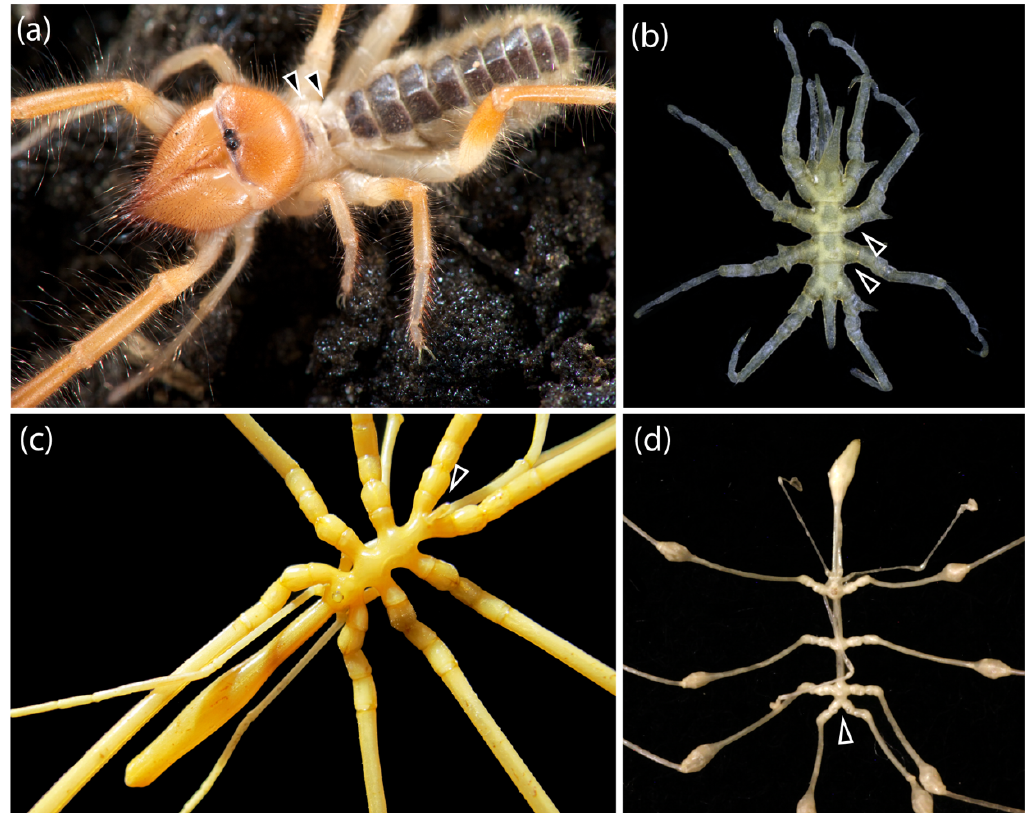
Figure 6. Incorrect codings of morphological character states underlie the recovery of Arachnida in morphological matrices. ( a ) Live habitus of Solifugae ( Eremobates sp.). Arrowheads show the locations of the third and fourth walking leg segments, which are not part of the carapace (the protruding coxae are clearly visible from a dorsal view). The same condition is found in Palpigradi. ( b ) Micro-CT of an austrodecid sea spider ( Austrodecus glaciale ). Arrowheads indicate the visible coxae of walking leg segments. ( c ) Unsegmented and appendage-free anal tubercle (the remnant of the opisthosoma; arrowhead) of a colossendeid sea spider ( Colossendeis megalonyx ). ( d ) Dorsal view of the colossendeid Rhopalorhynchus magdalena . In such species, the opisthosomal rudiment has been lost altogether (arrowhead). Note as well the absence of exopods in sea spiders. Photographs: ( a ) G. Giribet; ( b ) G. Brenneis; ( c , d ) C.P. Arango.